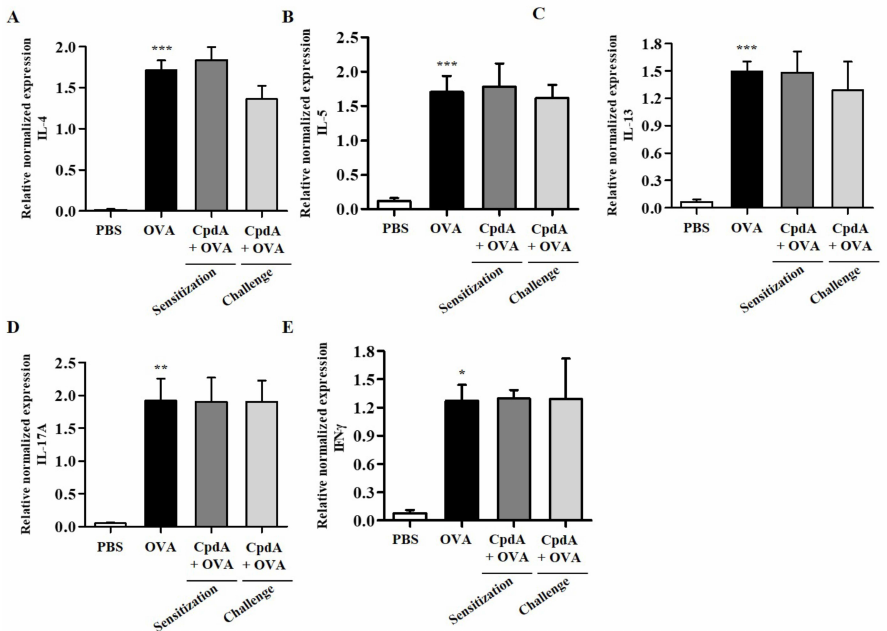
Figure 8. Effect of compound A on expression levels of T H 2, T H 17, and T H 1 cytokines in the BALF of OVA-induced asthma in FFA4-KO mice. Analysis of mRNA expression of T H 2 (IL-4, IL-5, and IL-13), T H 17 (IL-17A), and T H 1 (IFN- γ ) cytokines in BALF of OVA-induced and compound A- treated FFA4-KO mice. Relative mRNA levels of cytokines were quantified as ratios to GAPDH transcript levels. ( A ) IL-4, ( B ) IL-5, ( C ) IL-13, ( D ) IL-17A, and ( E ) IFN- γ . The results are presented as mean ± SEM ( n = 5). * p < 0.05, ** p < 0.01, *** p < 0.001 vs. the PBS-treated group.